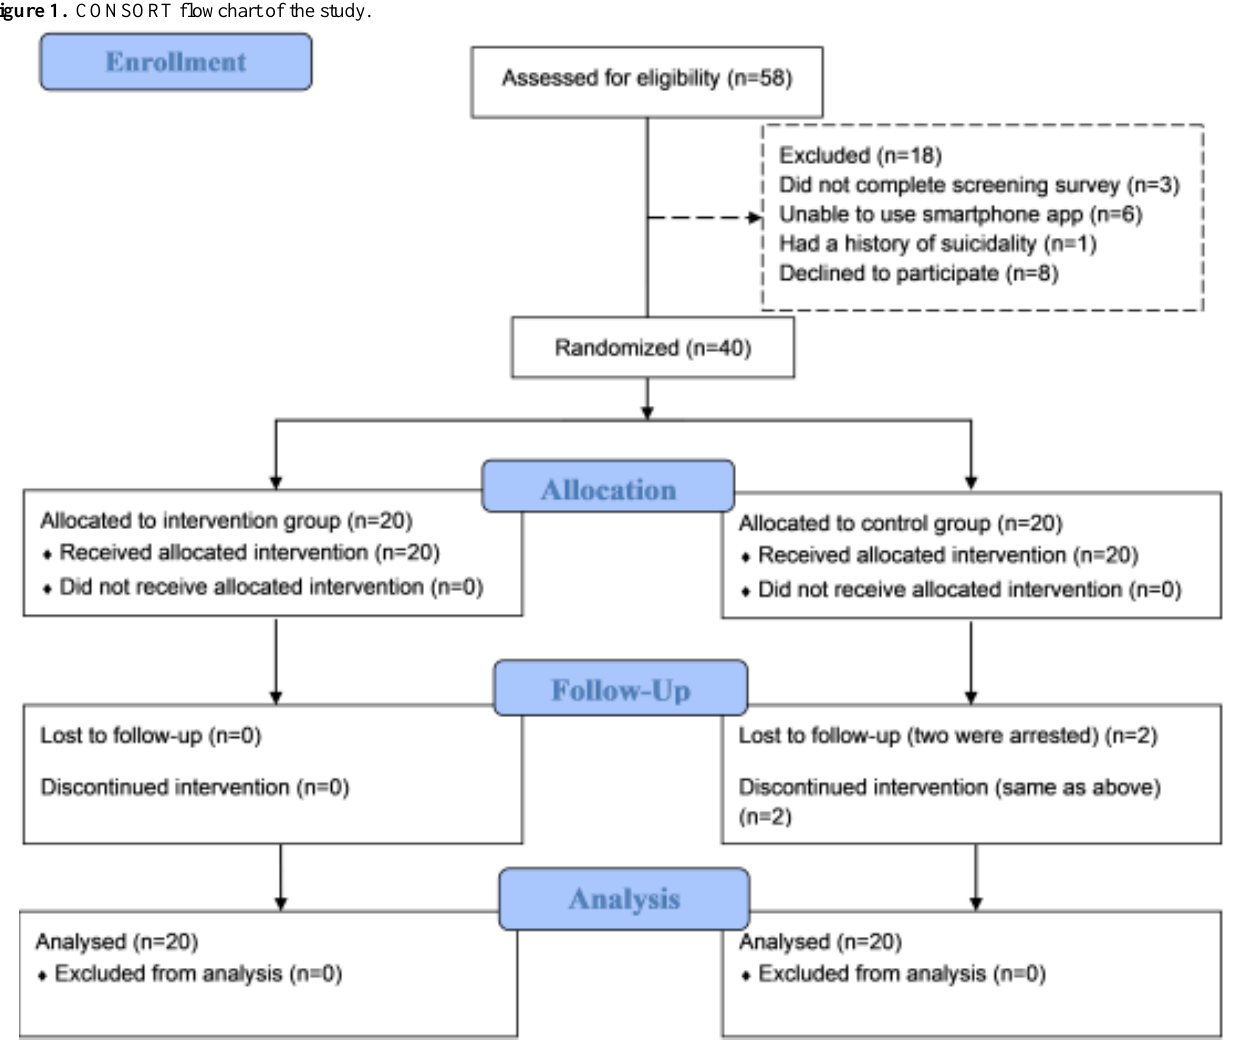
Figure 1. CONSORT flowchart of the